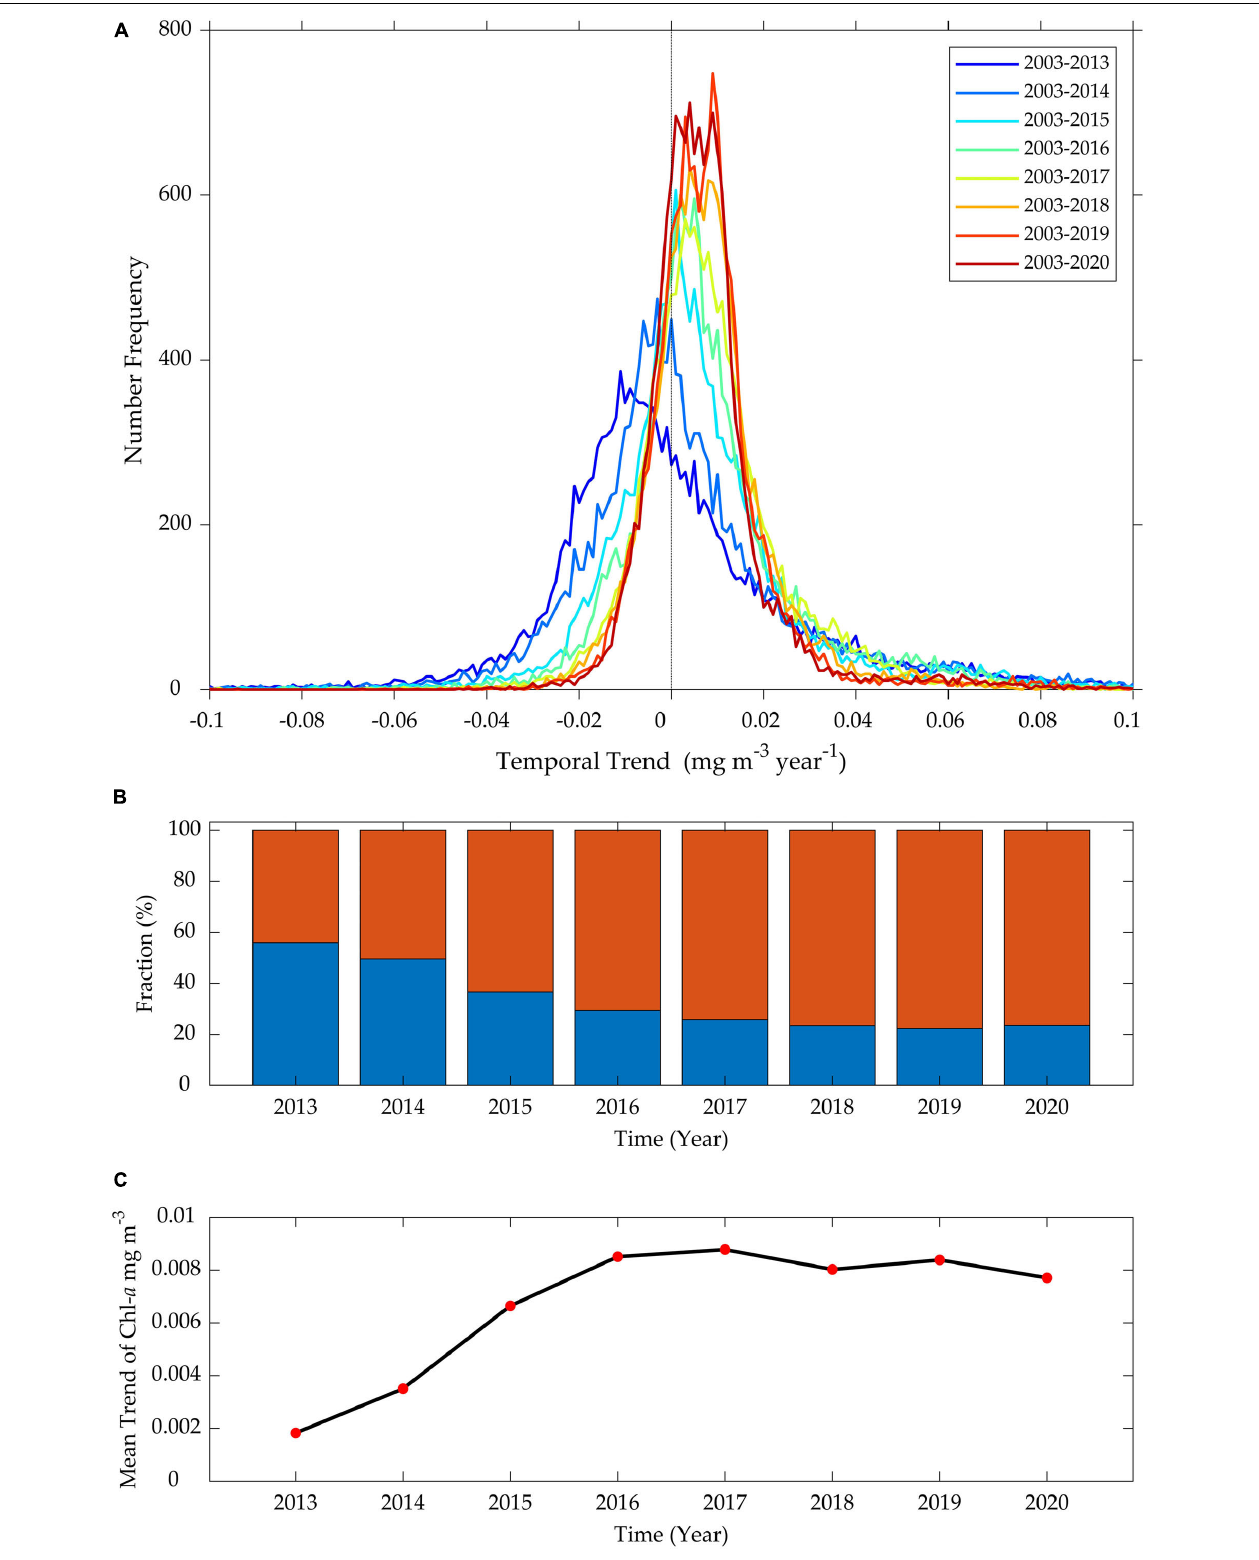
FIGURE 8 | (A) Distribution of frequencies of temporal chlorophyll- a concentration (Chl- a ) trends (mg m − 3 yr − 1 ) for the periods from 2003–2013 to 2003–2020, (B) yearly variations in fractions (%) of positive and negative trends (red and blue colors represent positive and negative trends, respectively), and (C) mean trends as a function of the end